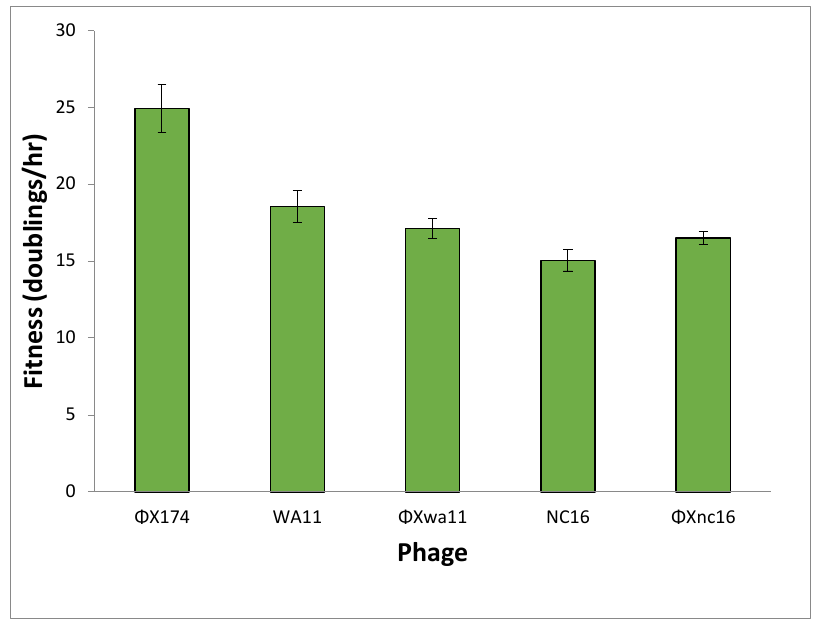
Figure 6. Fitness of each phage grown in E. coli C cells without plasmids. Both engineered phages are identical to ΦX174 except for two amino acid changes to match the reduction sequences of WA11 (ΦXwa11) and NC16 (ΦXnc16). Error bars indicate standard error.